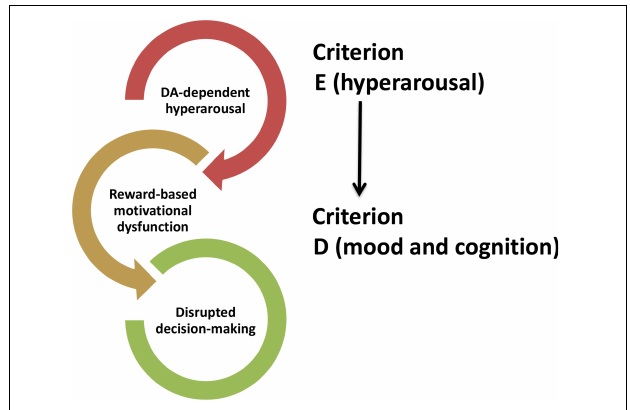
FIGURE 2 | Hypothetical influence of DA-induced hyperarousal (CRITERION E) on symptoms (CRITERION D) occurring in post-traumatic stress